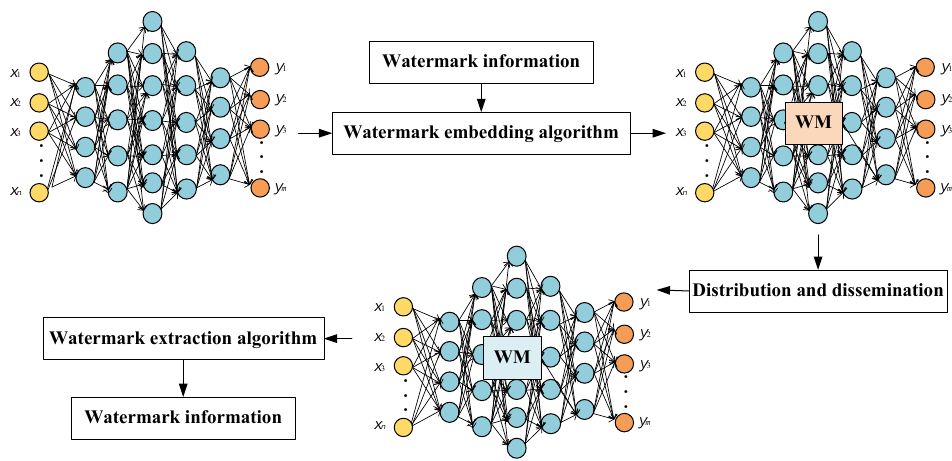
Figure 1. Neural network watermarking